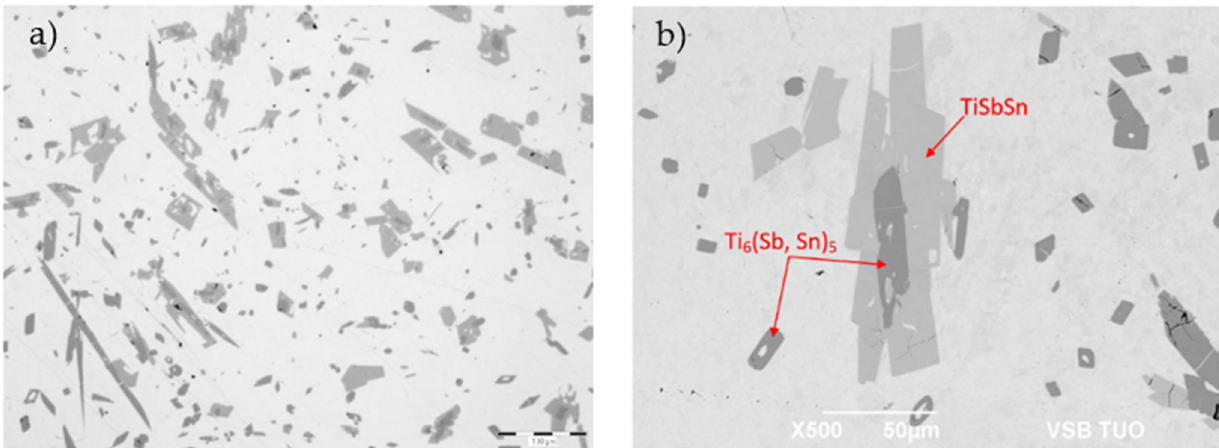
Figure 10 . Microstructure of the Sn5Sb3Ti phase; ( a ) from an optical microscope in the as-etched condition; ( b ) from SEM in BSE mode at a higher magnification. Table 4 . HV microhardness of individual components of the Sn5Sb3Ti solder .